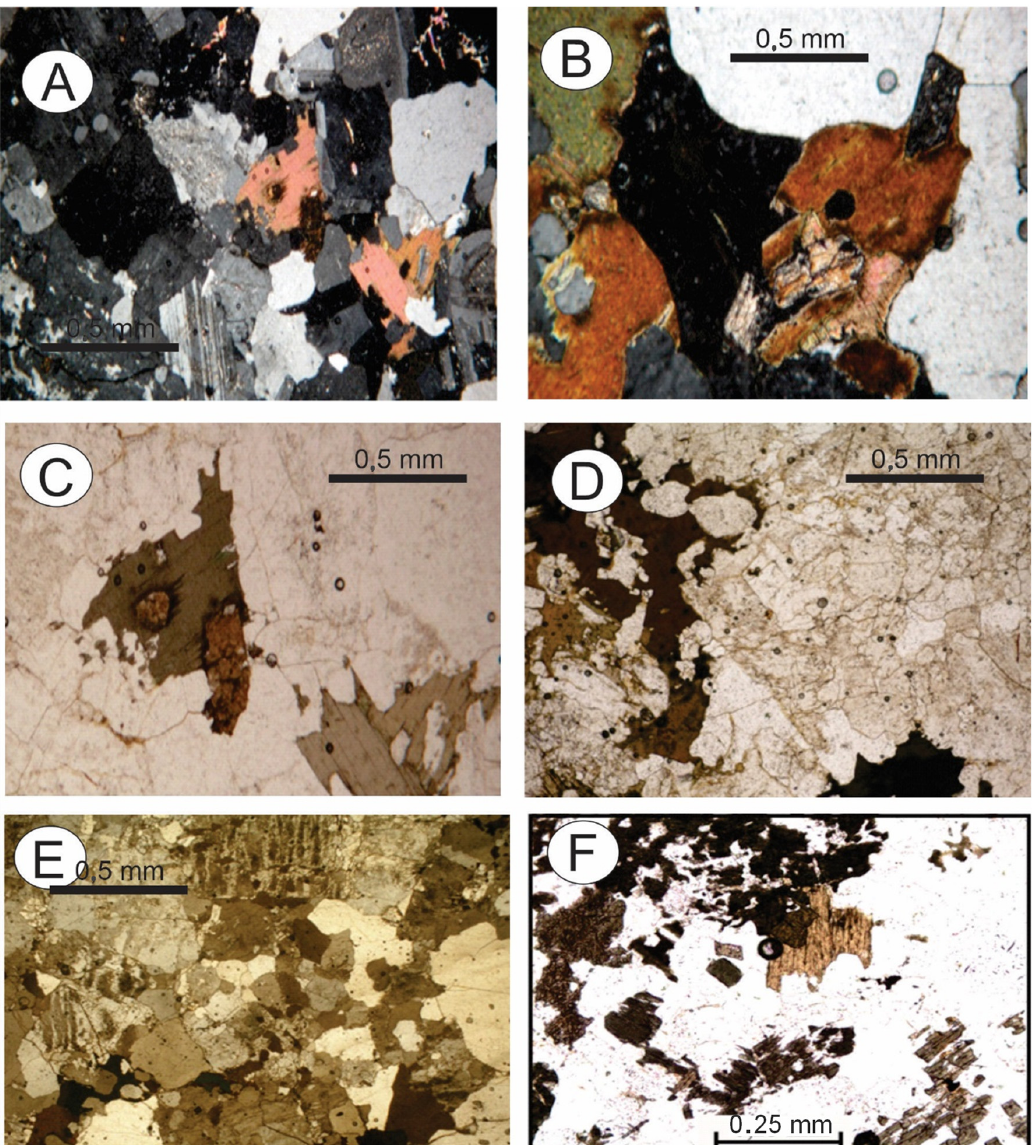
Figure 6. Microscopic features of Massangana intrusion; ( A ) Massangana porphyritic facies, showing matrix, composed of quartz and anhedral feldspar, the latter with sericitic alteration and hornblende; ( B ) Pyterlite porphyritic showing hornblende and oval K-feldspar phenocrysts and medium matrix. In ( C ) Bom Jardim Facies showing perthitic K-feldspar phenocryst in contact with biotite lamella and matrix; ( D ) detail with parallel nicols hornblende green crystals, intergrown with biotite; ( E ) Taboca Facies with sericitization of plagioclase; ( F ) S ã o Domingos medium gray to pinkish medium matrix granite with tabular K-feldspar phenocrysts with potassium alteration.